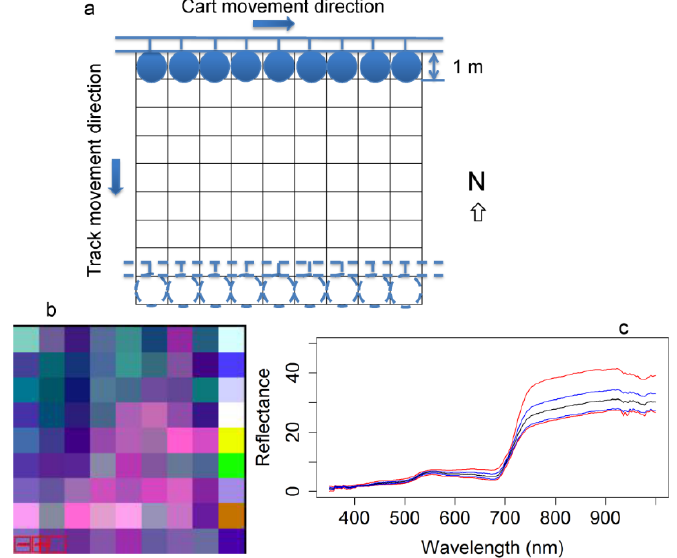
Figure 2. Design of whole-plot reflectance sampling ( a ) and example of synthetic image (plot 168, richness = 16) ( b ); and resulting reflectance spectra ( c ). Colored lines indicate mean (black), standard deviation (blue) and min/max (red) reflectance values. Reflectance spectra were used to calculate NDVI through time for comparison with nominal species richness (1–16).